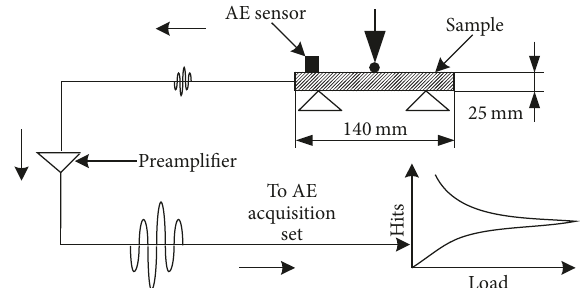
Figure 3: Experimental setup used for acoustic emission measure- ments